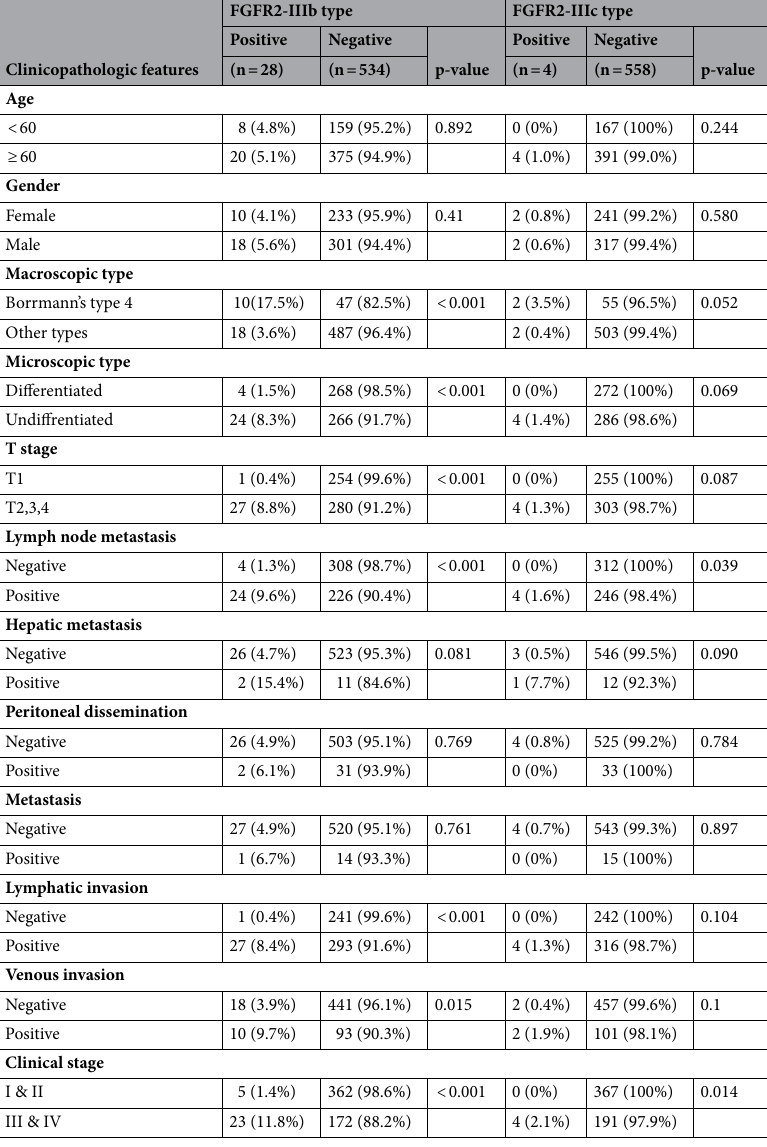
Table 1. Association between FGFR2-IIIb or FGFR2-IIIc expression and clinicopathologic factors in 562 primary gastric